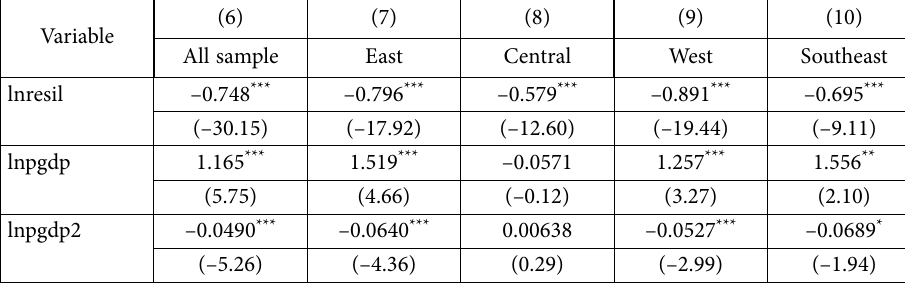
Table 6. The conditional β convergence coefficient estimation of the urban